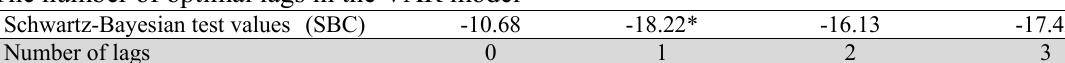
The number of optimal lags in the VAR model Schwartz-Bayesian test values (SBC)